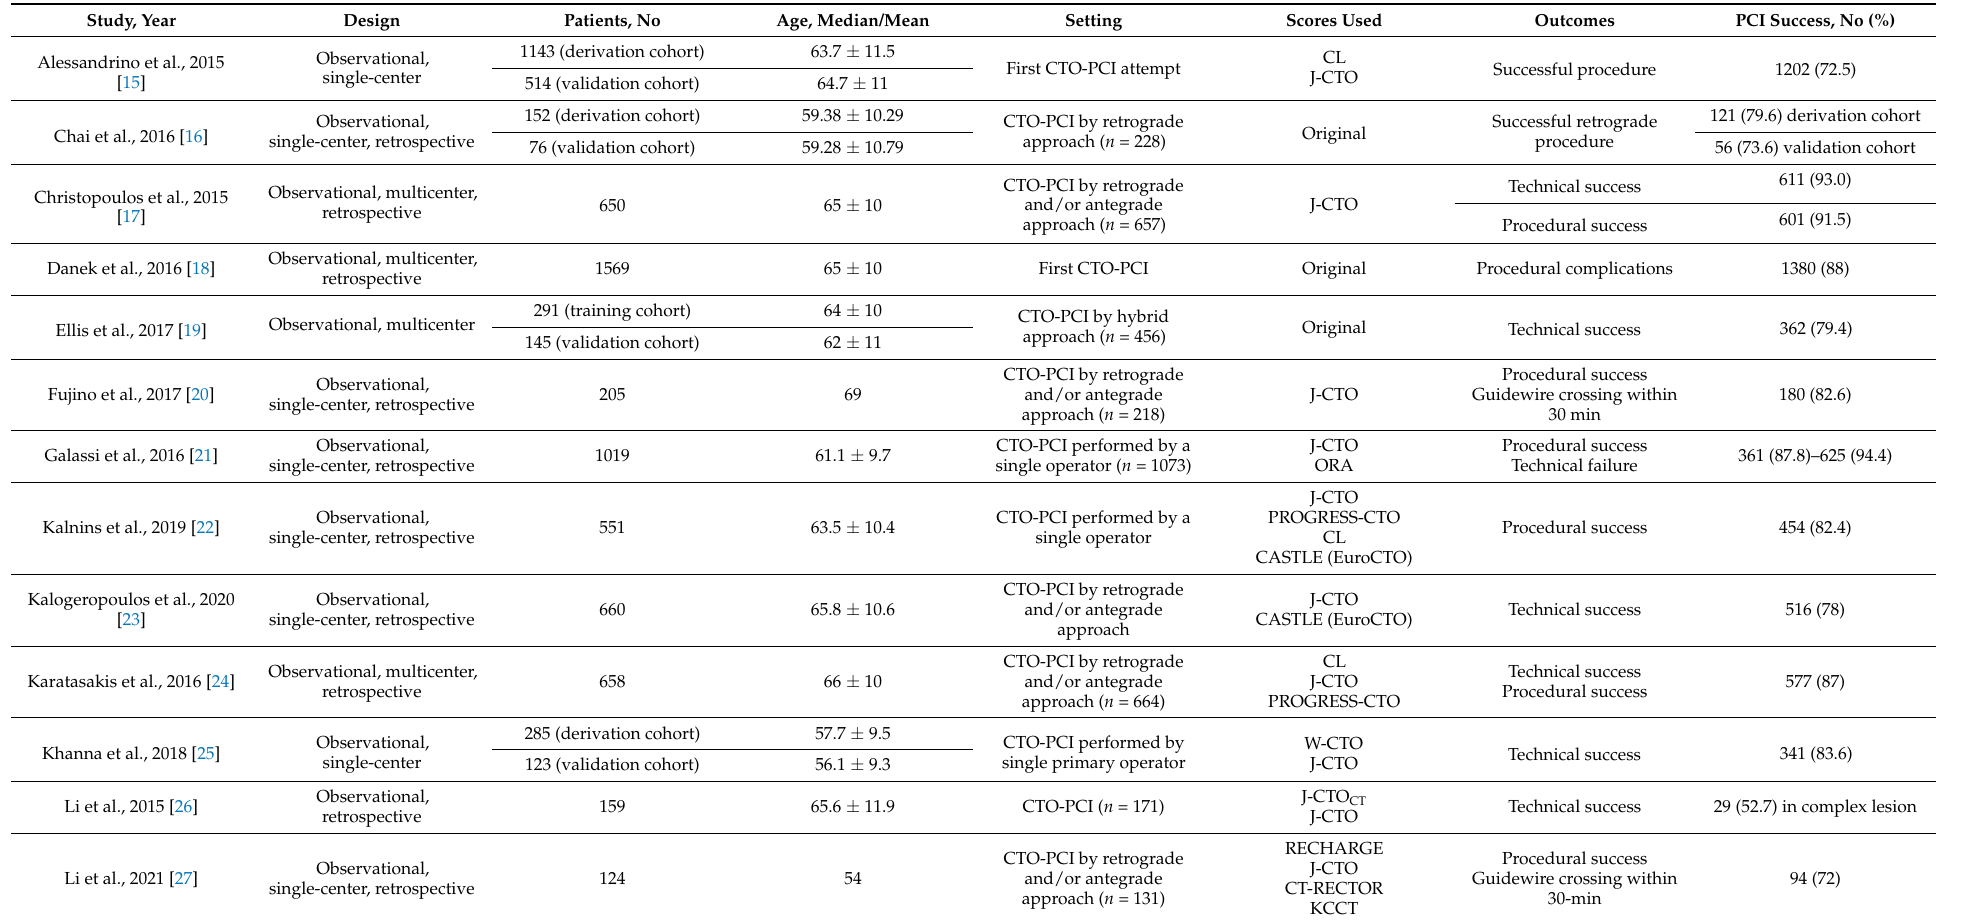
Table 1. General characteristics of studies included in the present systematic